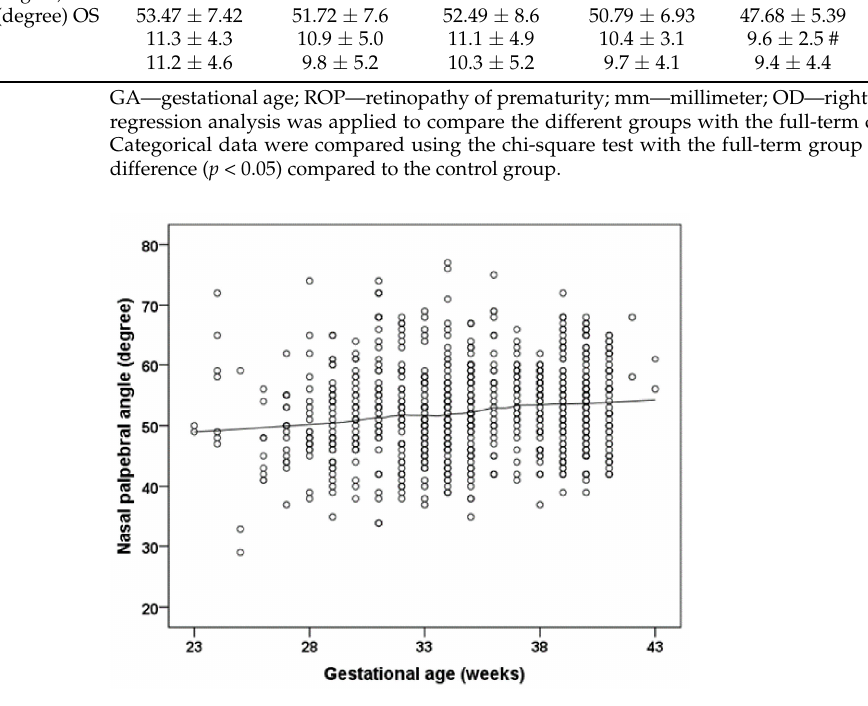
Figure 3. The relationship of gestational age to the nasal palpebral angle. Figure legend 3: Participants with lower gestational age reveal a smaller nasal palpebral angle. The line presents the Loess (Locally Weighted Scatterplot Smoothing) curve.